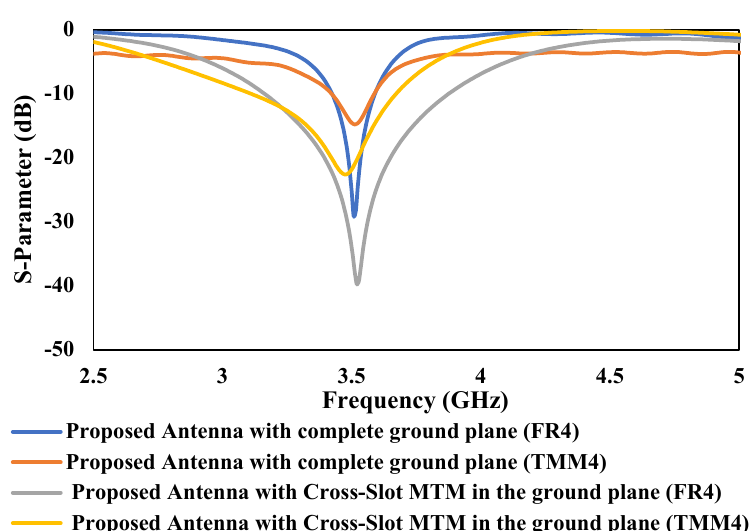
Figure 11. S-Parameter response of both proposed antennas using different substrate.